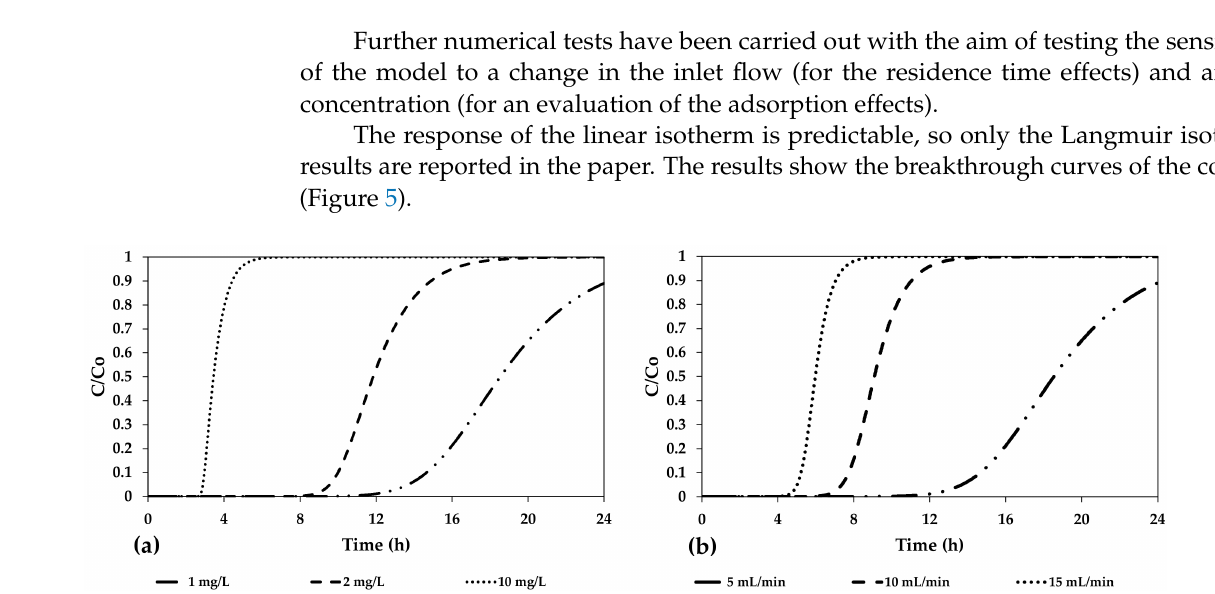
Figure 5. The breakthrough curve obtained by numerical simulations increasing the As concentration ( a ) and the flow of the inflowing solution ( b